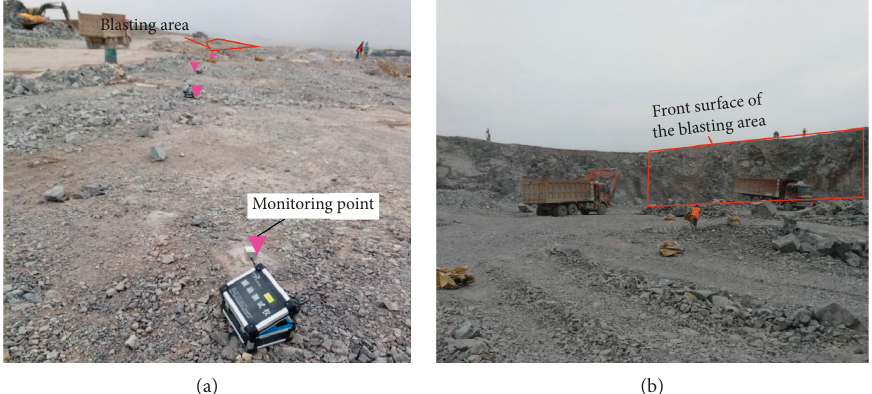
Figure 23: Pictures of the experiment area in the production blasting. (a) Bird view of the blasting area. (b) Front view of the blasting area.